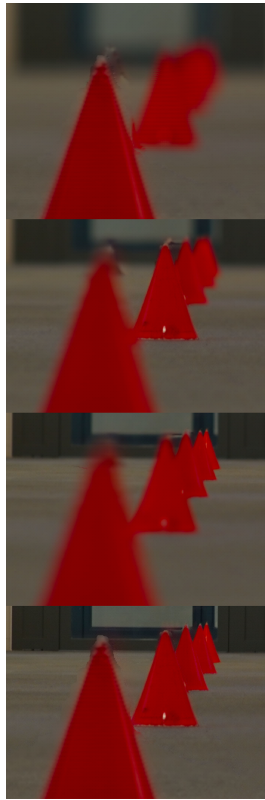
Figure 1. Light field image acquired with Lytro Illum and refocused after image acquisition for close, middle, far and complete image.